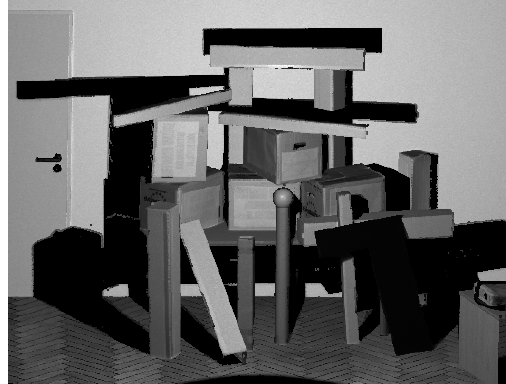
Figure 5. Ground truth data captured for a three-dimensional scene using a terrestrial laser scanner (Leica HDS